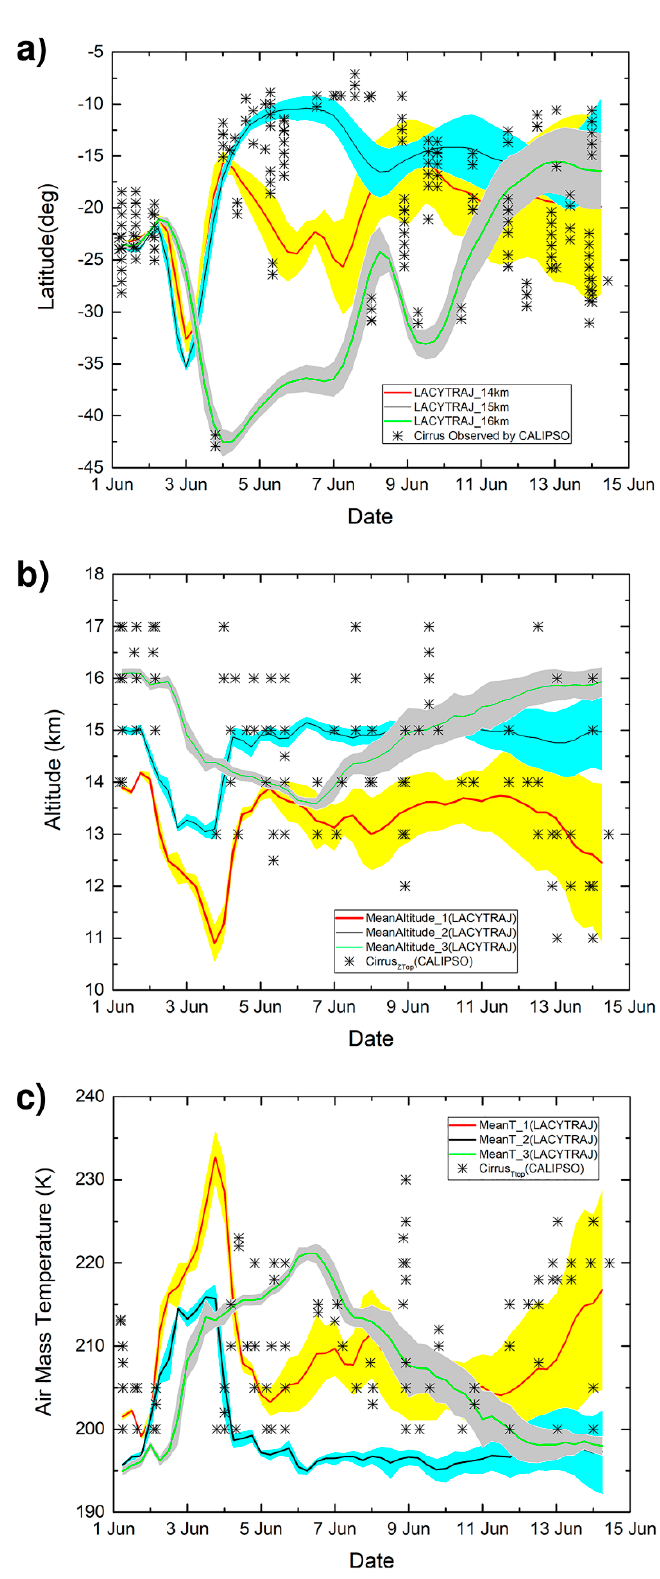
Figure 7. Track matching between CALIPSO (presence of cirrus detected) and LACYTRAJ air mass trajectories during 14 days in a latitude range of − 45° to − 5°. The corresponding latitude ( a ), altitude ( b ), and temperature ( c ) of cirrus extracted from CALIPSO are shown for the same period. The shaded area on the modeled curves represents the standard deviation.